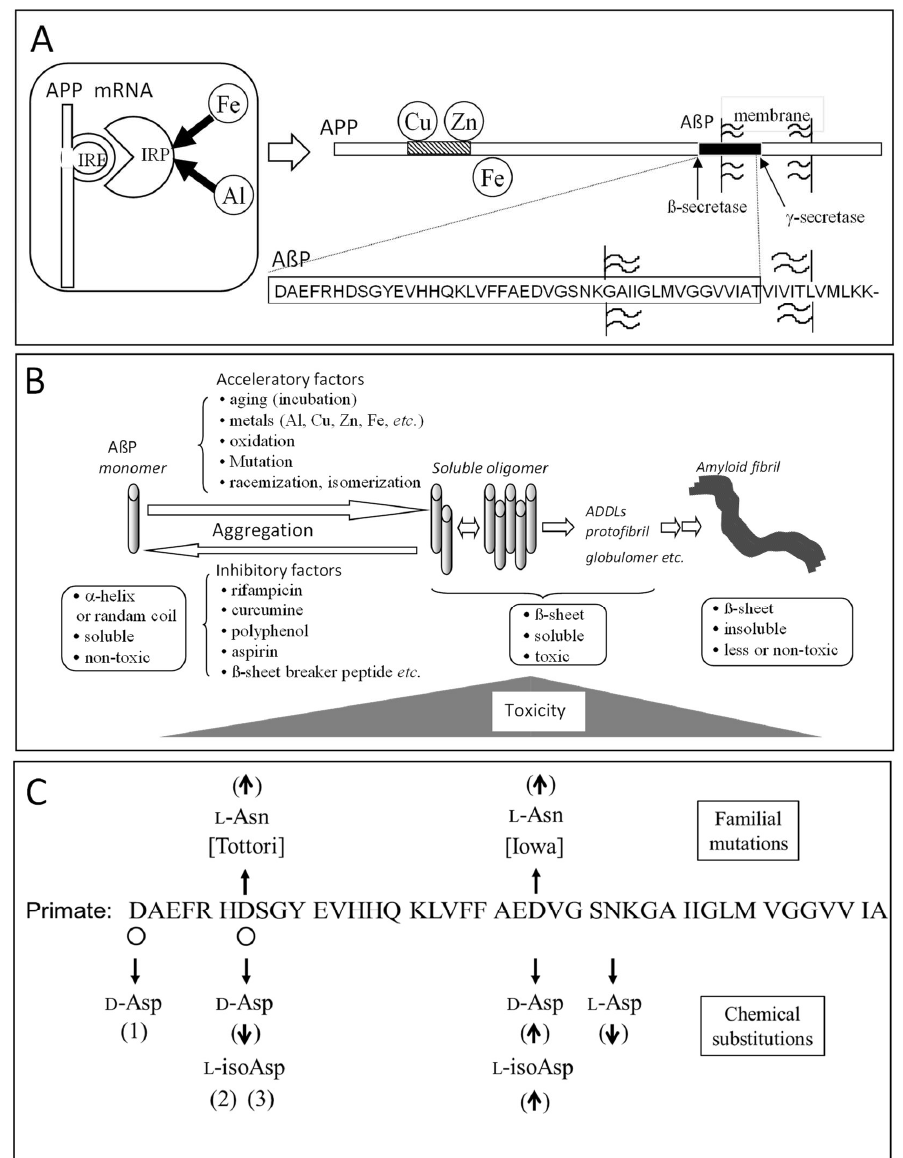
Figure 3. Alzheimer’s disease and factors affecting A β P aggregation. ( A ) Structure of APP and A β P. A β P is secreted by cleavage from its precursor protein, APP by transmembrane cleavage. The mRNA of APP possesses IRE domain, and Fe regulates its expression. ( B ) A β P aggregation. A β P self-aggregates and forms several types of oligomers (including SDS-soluble oligomers, ADDLS, globulomers, or protofibrils) and finally forms insoluble aggregates termed amyloid fibrils. Oligomeric soluble A β Ps are toxic, although the monomeric and fibril A β Ps are rather nontoxic. The aggregation process is influenced by the acceleratory factors or the inhibitory factors. ( C ) Summary of Asp isomerization in A β P. The Asp isomerization positions found in an AD brain are indicated by open circles. The relationship between chemical substitution and fibril formation is also shown. ( ↑ ) acceleration or increase of fibril formation, ( ↓ ) suppression or decrease, (1) suppression of acceleration effect by Asp 23 substitution [41], (2) unchanged in vitro assay, (3) triggered the dense-core congophilic amyloid plaque formation in APP transgenic mice. The comparison between the sequence of primate (human or monkey) A β P 1–42 and rodent (rat or mouse) A β P 1–42 is also depicted and the different amino acids are indicated by